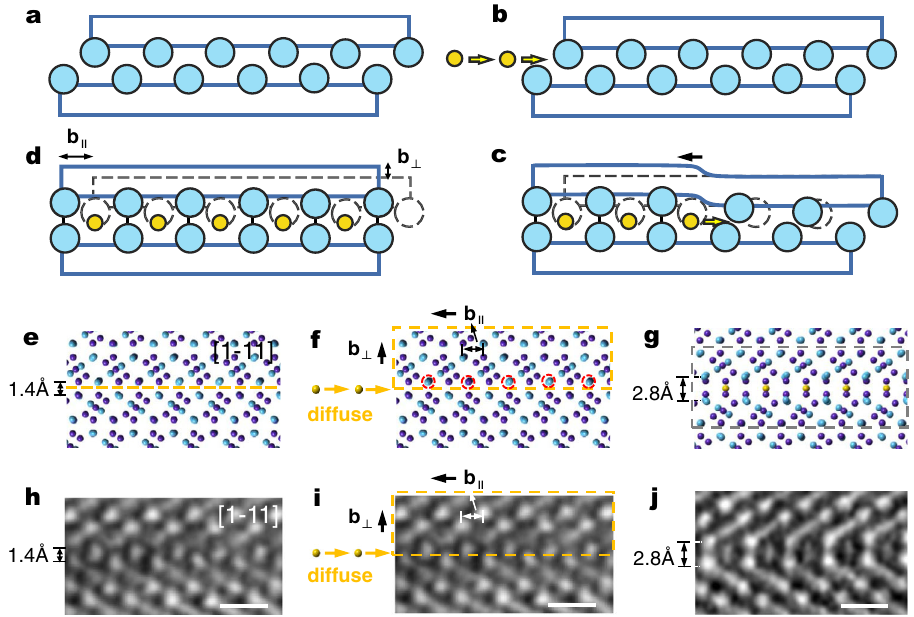
Fig. 2 The transformation path from the (110) FTB of μ phase to the partial structure of P (or σ ) phase. Note that the hexagonal description is also often used for the rhombohedral μ phase. Some typical plane/orientation relationships are: (110) corresponds to (1-12) H , [1-11] corresponds to [42-1] H , and [1- 10] corresponds to [110] H . Please refer to Supplementary Fig. 1 for details. a – d Schematic illustration of the transformation process via dislocation climb. a The original FTB of the μ phase. b Smaller metal (yellow) atoms diffuse into the FTB. c The resultant dislocation, resembling a Frank interstitial loop, climbs to the right, converting the local structure into that of the P phase, which is shown in ( d ). Note that the Burgers vector of the climbing dislocation has both a parallel and a vertical component. e – j illustrate the details using an atomic model. The purple and blue atoms represent (Co, Cr, Ni) and (W, Mo, Re), respectively. e Atomic model of the FTB, projected along [1-11] μ . The orange dotted line marks the interface position of the FTB, into which the small atoms (represented by yellow balls) in ( f ) diffuse/insert. f An extra row of atoms gradually diffuse into the FTB; see Supplementary Fig. 8 for additional information and red dashed circles. All the atoms inside the orange dotted box experience translational displacement with Burgers vector b ∥ = 1/2[1-10] and vertical displacement with b ⊥ (its magnitude is 1.4 Å), resulting in ( g ), a partial structure of P phase. h – j The HAADF images corresponding to the atomic model projections in ( e – g ). Scale bars of ( h – j ) are 0.5